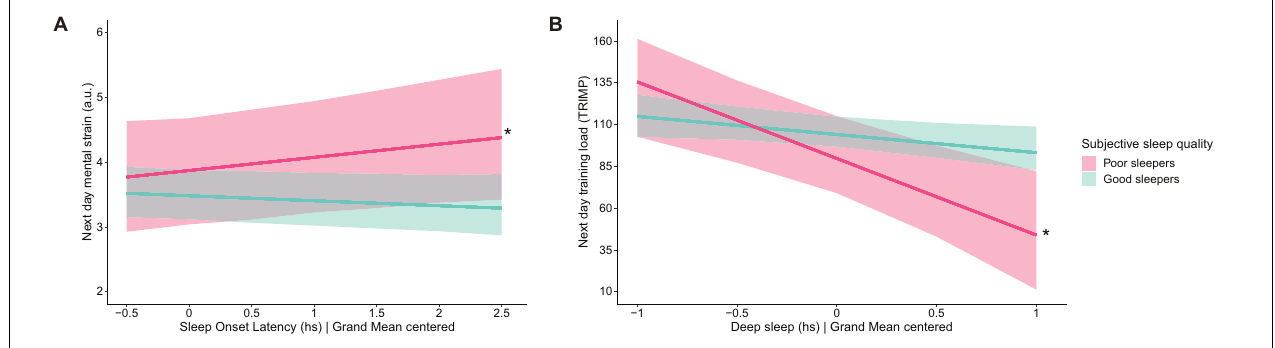
FIGURE 6 | Significant findings identified when testing the moderating role of subjective sleep quality in 56 junior endurance athletes: (A) effect of sleep onset latency on next day mental strain and (B) effect of deep sleep on next day training load. The red bold line represents the average intercept and slope identified for poor sleepers, while the turquoise line represents the average intercept and slope identified for good sleepers. The shaded area above each line represents the upper 2.5% of 95% credibility interval, while the shaded area below each line represents the lower 2.5% of 95% credibility interval. Value 0 on the x -axis refers to the average value on the measured outcome parameter. * denotes significant difference between poor and good sleepers, p <